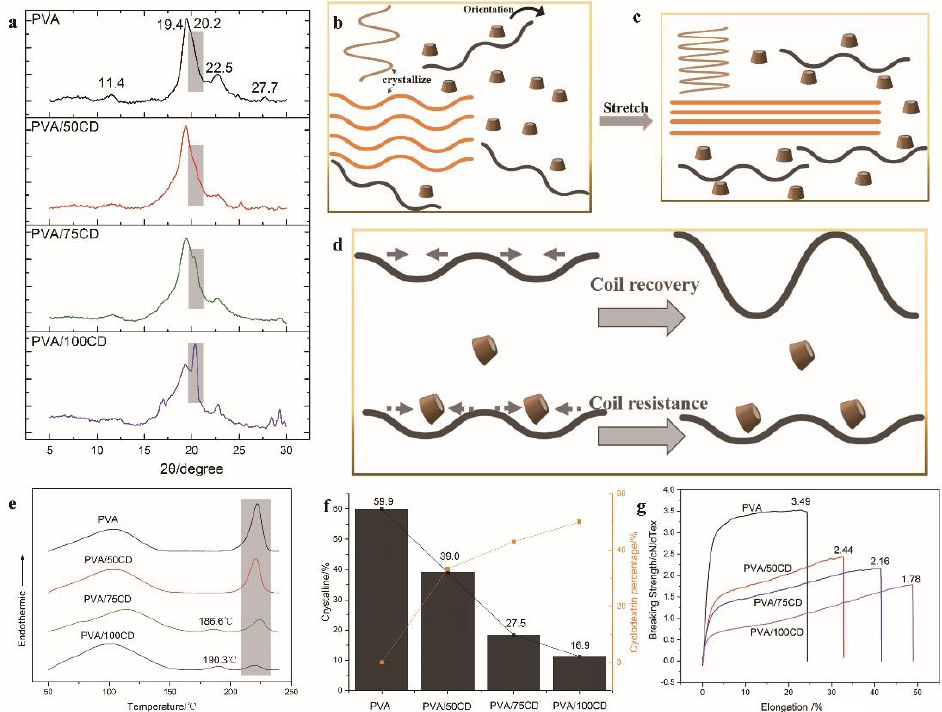
Figure 2. ( a ) XRD results of PVA, PVA/50CD, PVA/75CD and PVA/100CD fibers; illustration of the structure of ( b ) PVA/CD fibers before hot stretching, ( c ) after hot stretching and ( d ) coil resistance behavior; ( e ) DSC results of PVA, PVA/50CD, PVA/75CD and PVA/100CD fibers; ( f ) crystallinity ratio of PVA, PVA/50CD, PVA/75CD and PVA/100CD fibers; ( g ) mechanical properties of PVA, PVA/50CD, PVA/75CD and PVA/100CD fibers.